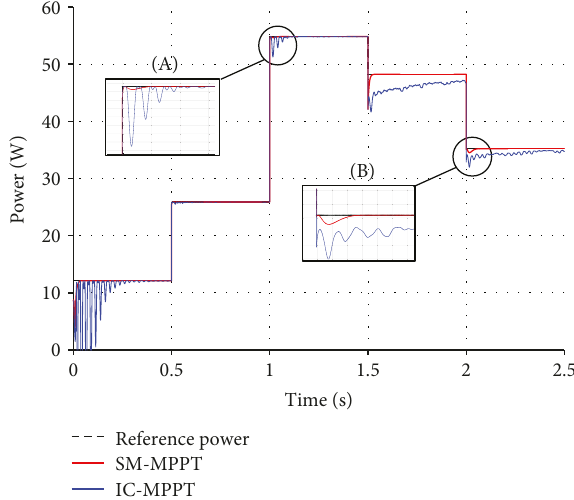
Figure 9: Output power of the SM55 PV panel using the SM-MPPT and IC-MPPT.